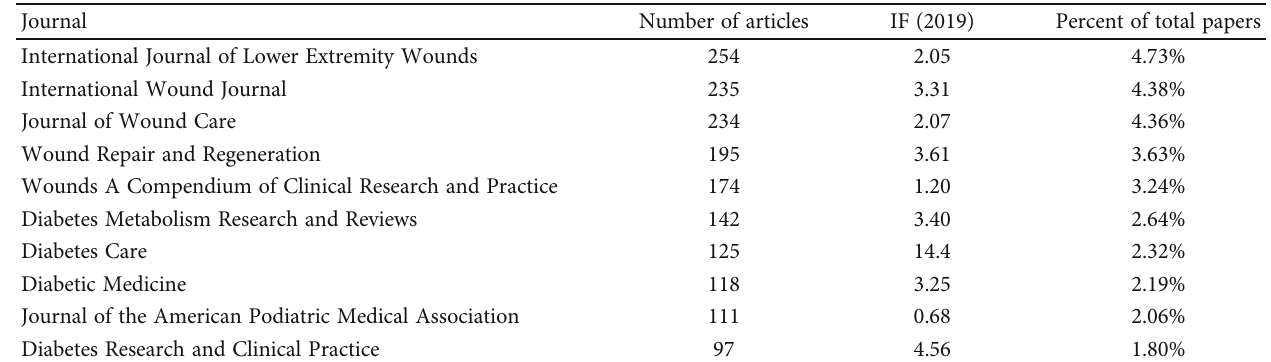
Table 1: Top 10 contributory journals.